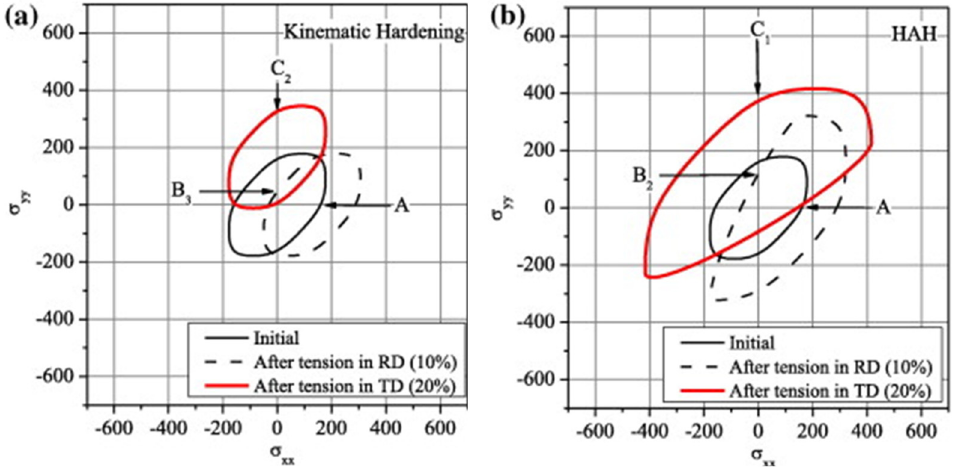
Figure 11. Yield loci during tension (up to 10% strain) followed by orthogonal tension (up to 20% strain) with ( a ) kinematic hardening and ( b ) HAH model. Reprinted from Ref. [182] with permission. Copyright 2012, Elsevier.